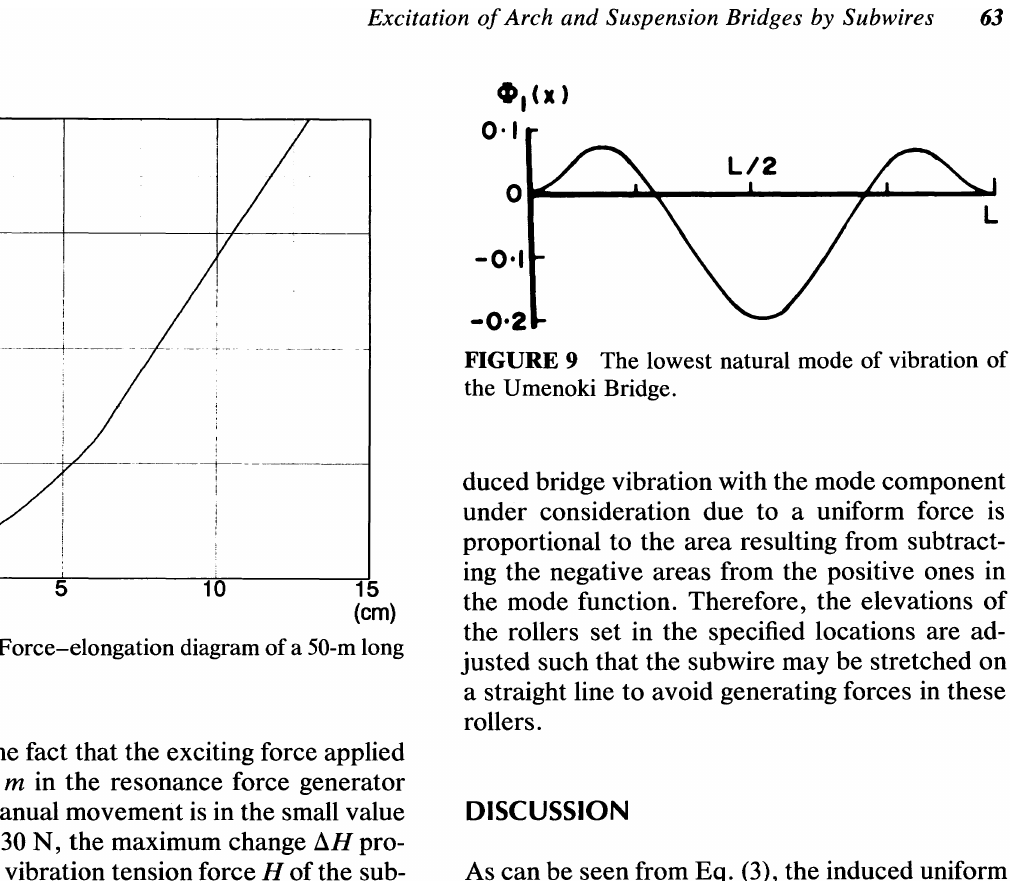
FIGURE 10 Arrangement of running blocks and ac